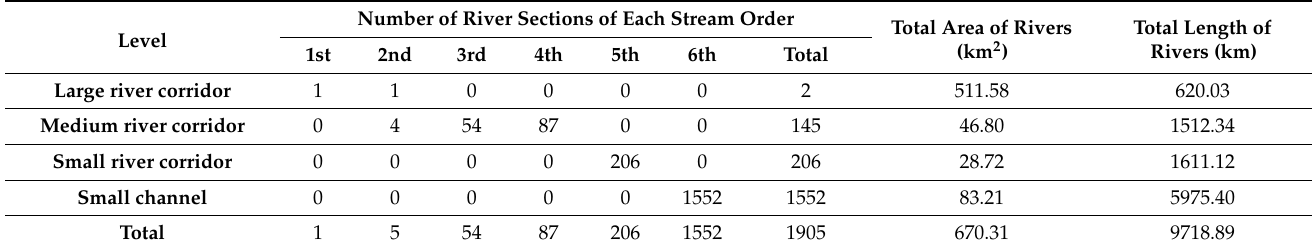
Table A2. Identification result statistics of river corridors at all levels.